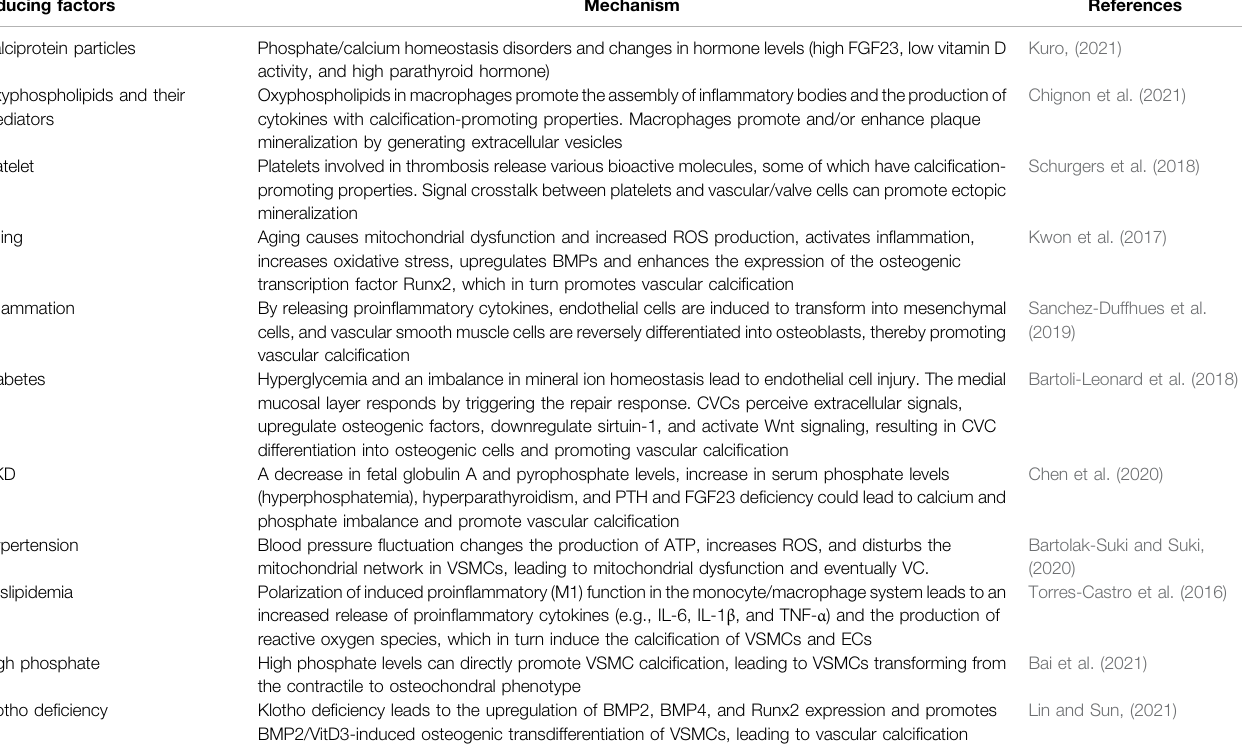
TABLE 1 | Inducing factors and the mechanism of vascular calci fi